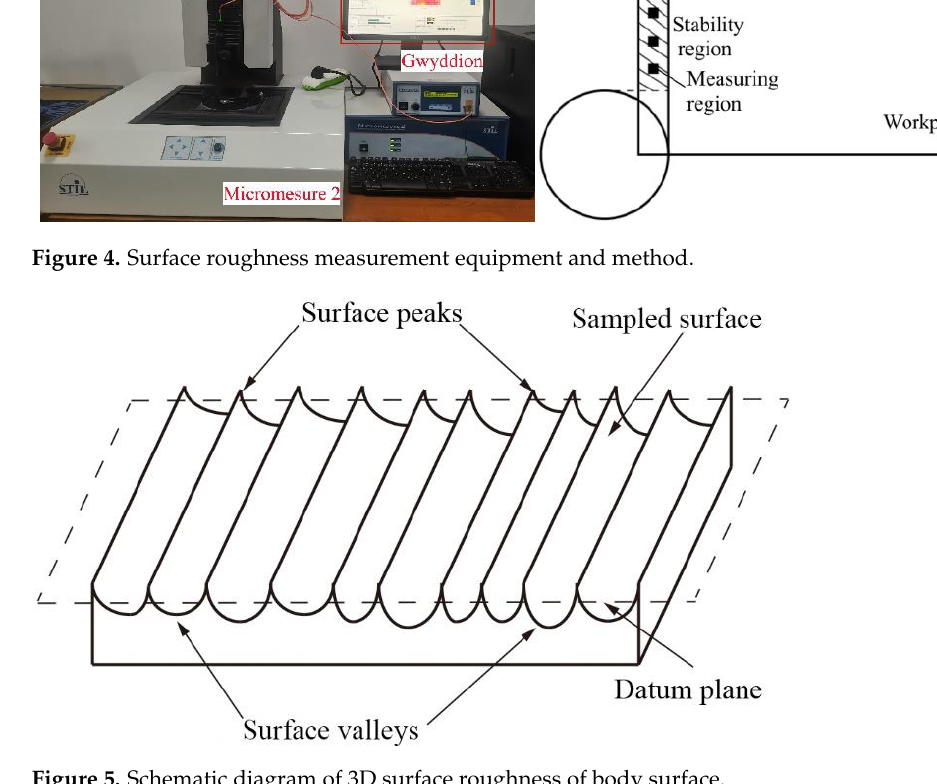
Figure 5. Schematic diagram of 3D surface roughness of body surface. Table 3. Three-dimensional surface roughness parameters.